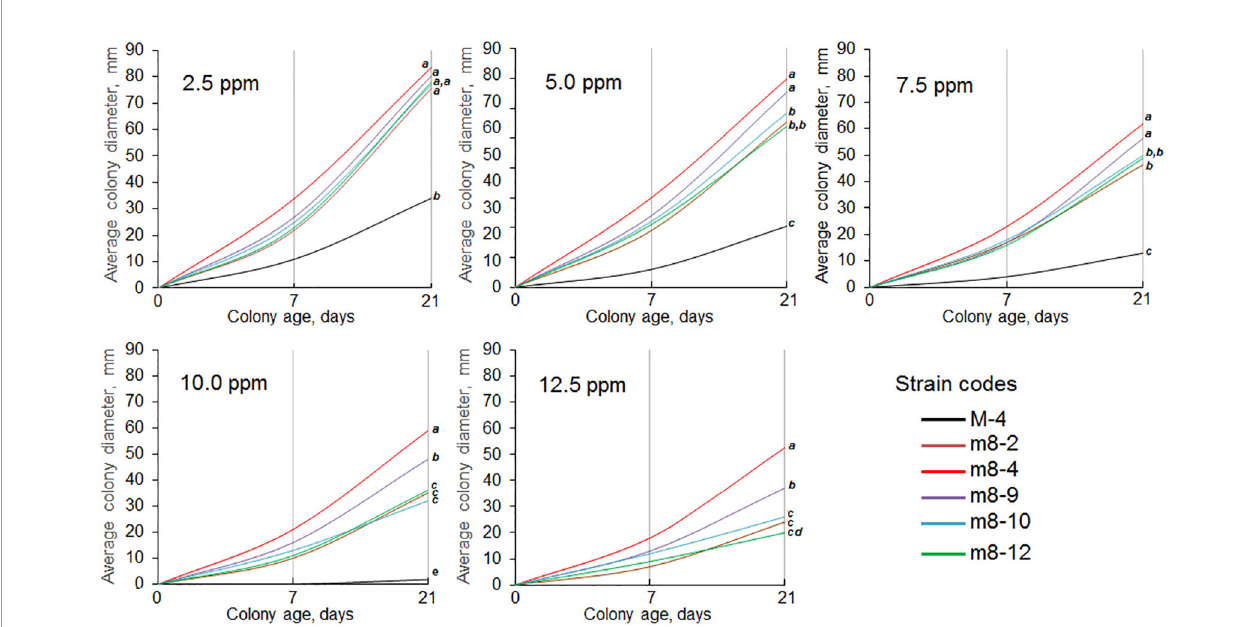
FIGURE 2 | Dynamics of radial growth of fi ve P. nodorum strains resistant to tebuconazole cultured on CDA containing Folicur ® at concentrations ranging from 2.5 to 12.5 ppm. Strain M-4 is the parental, wild strain. Differences between average colony diameters marked with the same bold italic letters, at the right margin of the graphs, show insigni fi cant ( p > 0.05) differences by termination of cultivation. For additional explanation, see Figure 1 .